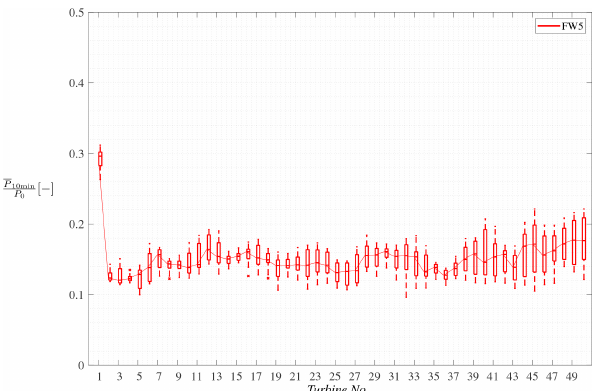
Figure 4. Violin plots comparing the influence of turbulence inten- sity on the instantaneous power production in DTU2 (black) with TI = 3% and DTU3 (blue) with TI = 15% for turbine spacings of S X × S Y = 12 R × 20 R .